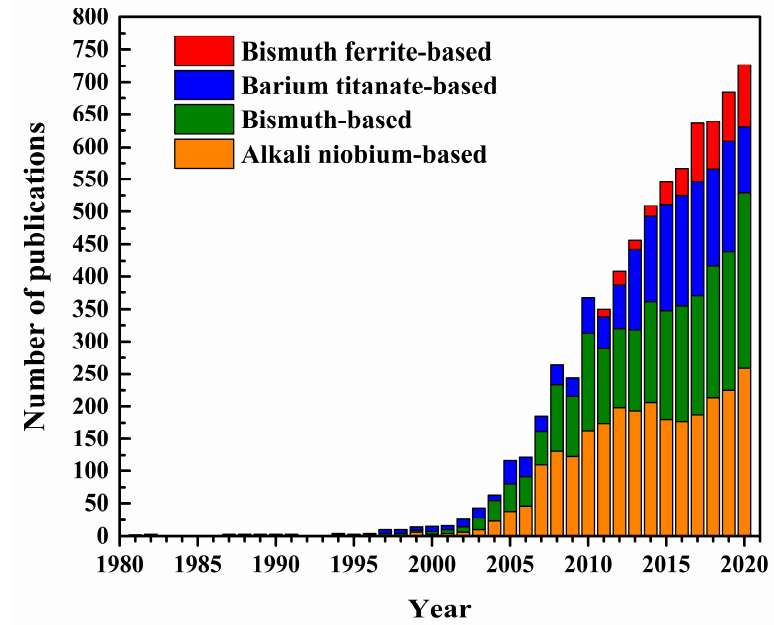
Figure 1. Evaluation of research output for lead-free piezoceramics over the last 40 years. Number of publications was investigated by searching for “piezoelectrics”, “lead-free”, and “piezoceramics” in Web of Science [11], each publication was manually checked for relevance.